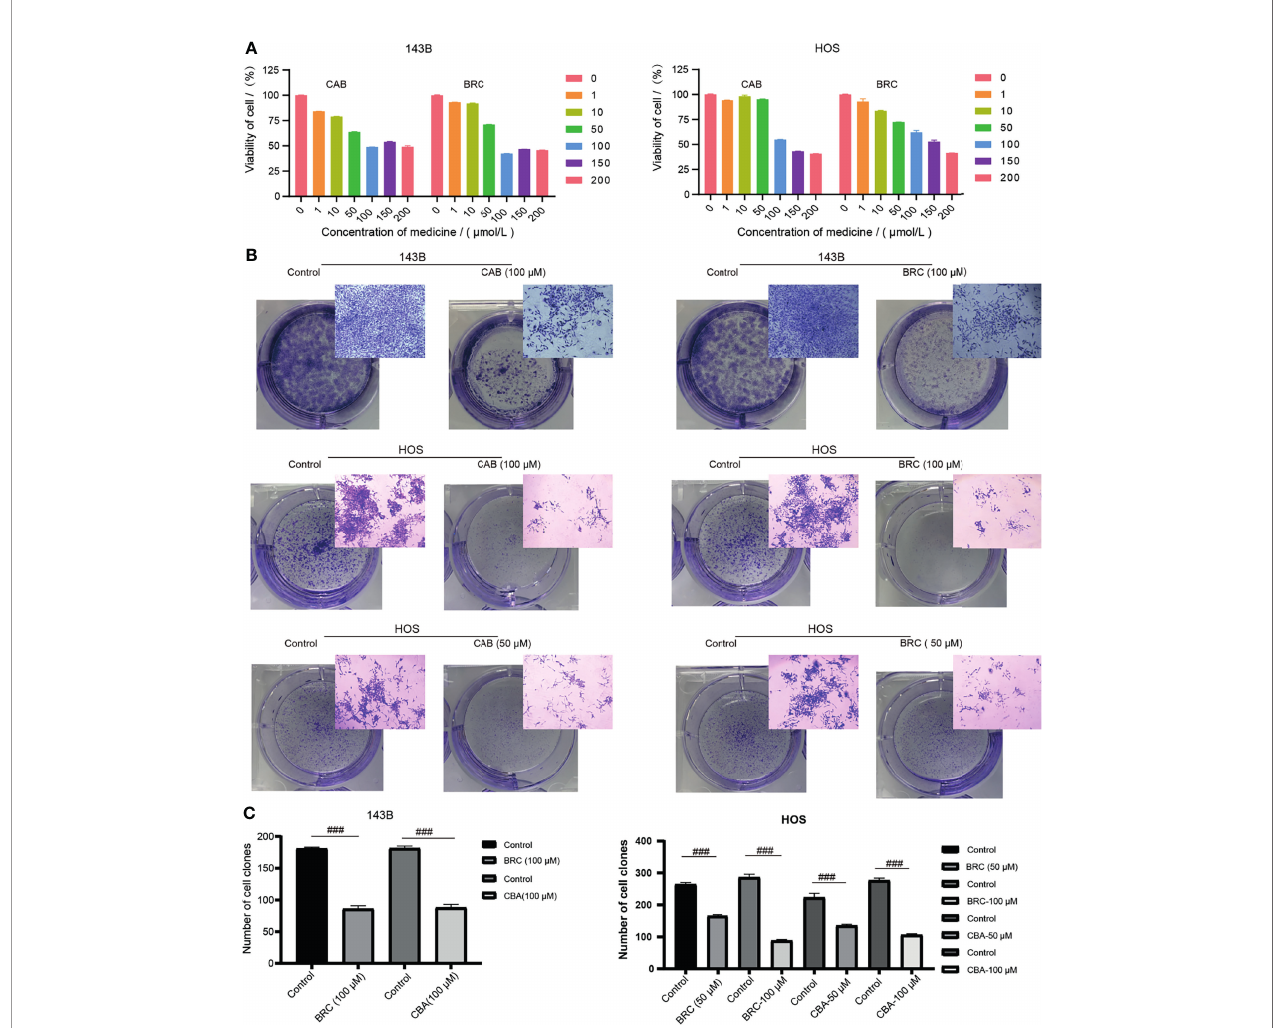
FIGURE 9 | (A) Different concentrations of cabergoline and bromocriptine on the viability of 143B and HOS cell line, three repetitions. (B) The results of the colony formation experiment, including the well-plate image and microscope image, three repetitions. (C) Quantitative comparison of the number of the colony in the well- plate, “ ### ” represents p < 0.001, n = 3. CAB, Cabergoline; BRC,